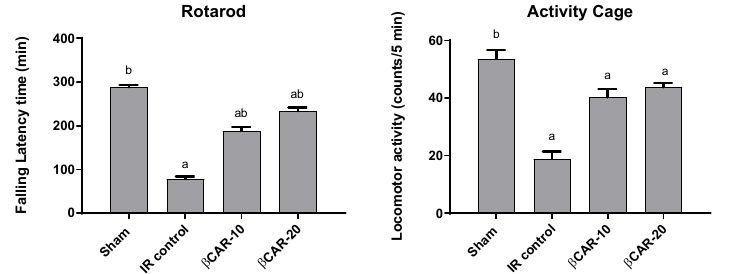
Figure 2. Effect of β CAR on motor coordination (rotarod) and locomotor activity (activity cage) in I/R control rats. a, b denotes significant difference at p ≤ 0.05 against sham and I/R control groups, respectively, ( n = 6).